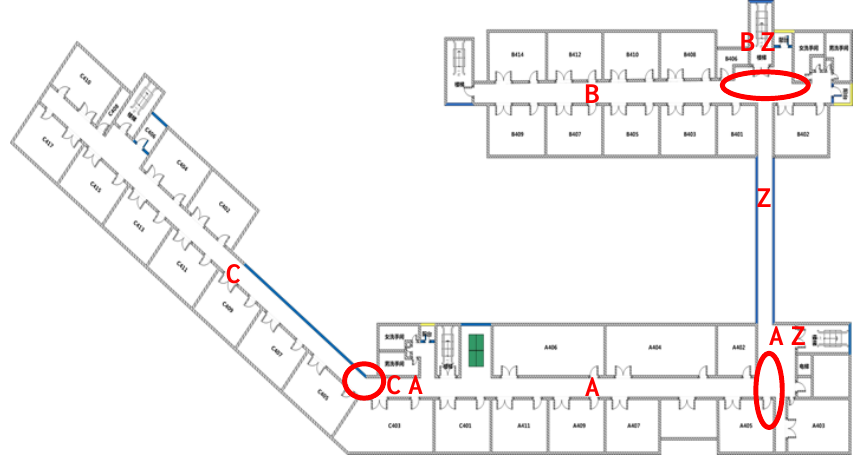
Figure 3. Cartographic zoning plan.